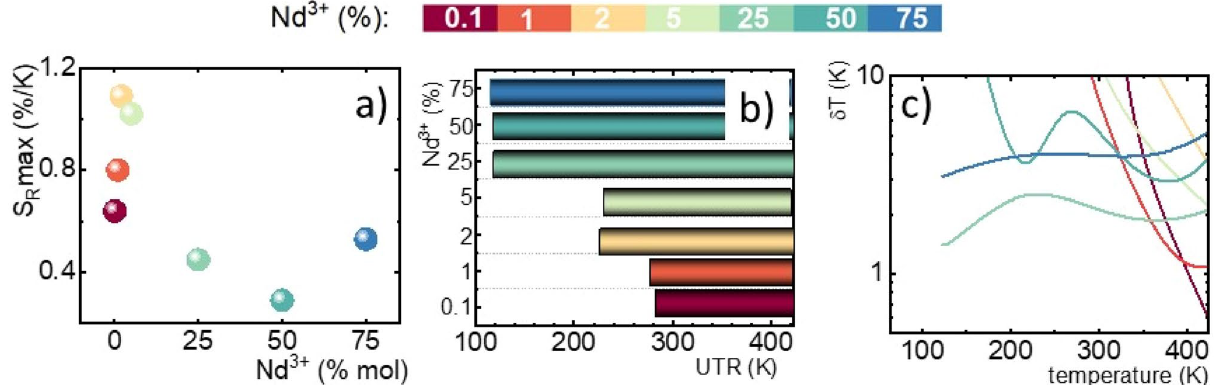
Figure 4. The maximum relative sensitivity ( a ); an usable temperature range (UTR) ( b ); and temperature determination uncertainty ( c ) for different Nd 3+ concentration in NaYF 4 :Nd 3+